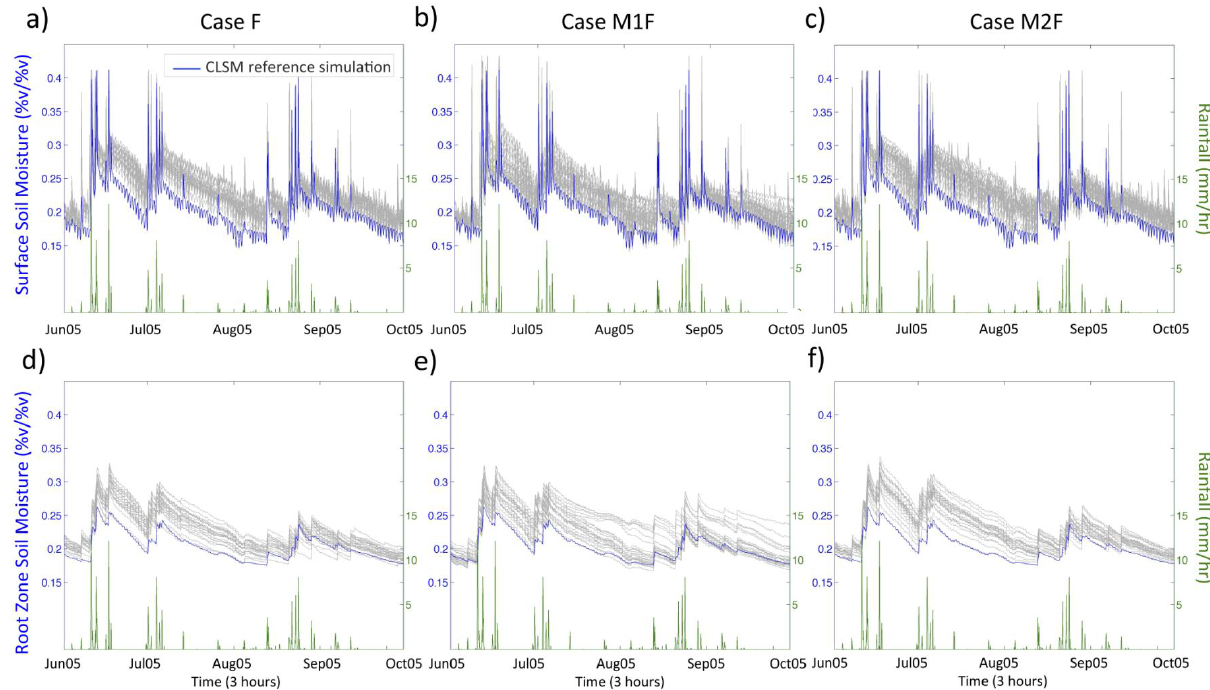
Figure 8 Same as in Figure 7 but for the representative 25km grid cell shown in Figure 6, located in the western region of the study 823 Fig. 8. Same as in Fig. 7 but for the representative 25km grid cell shown in Fig. 6, located in the western region of the study area. Table 4. Mean exceedance and uncertainty ratios for surface soil moisture (in regular style) and root zone soil moisture (in